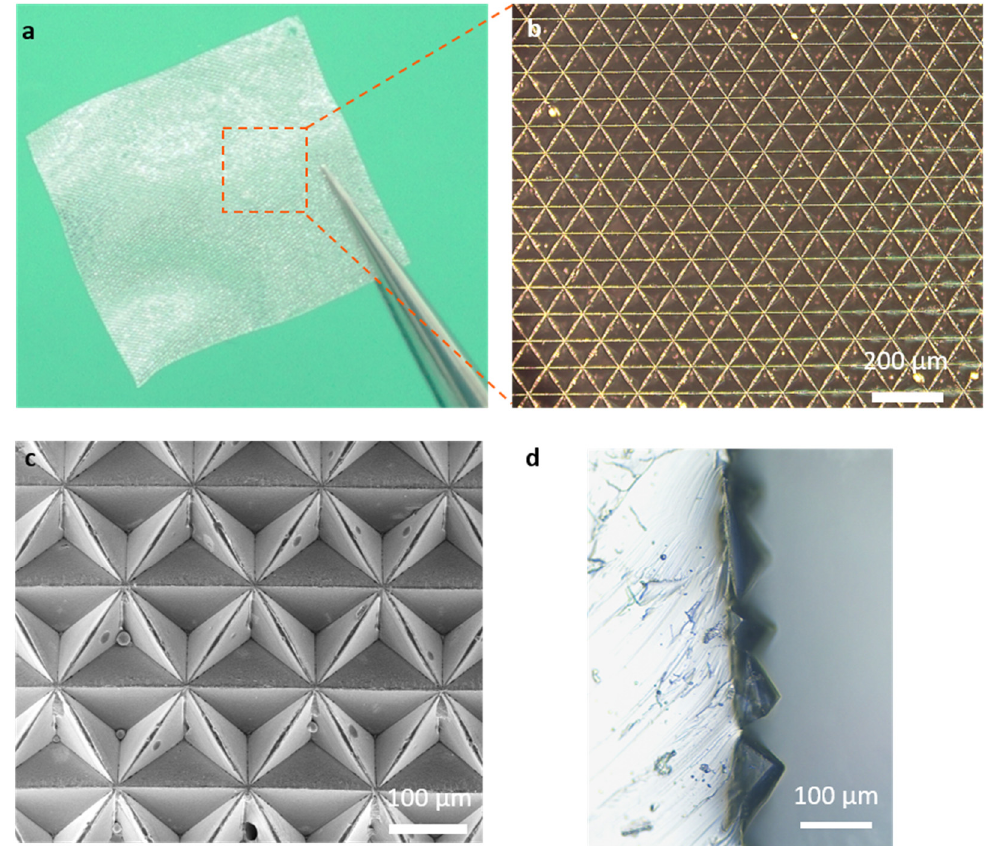
Figure 3. Characterization of the ionic film for flexible sensors. ( a ) Low and ( b ) high magnification of the optical image of the ionic film. ( c ) SEM image of the ionic film. ( d ) Cross-sectional view of the ionic film.